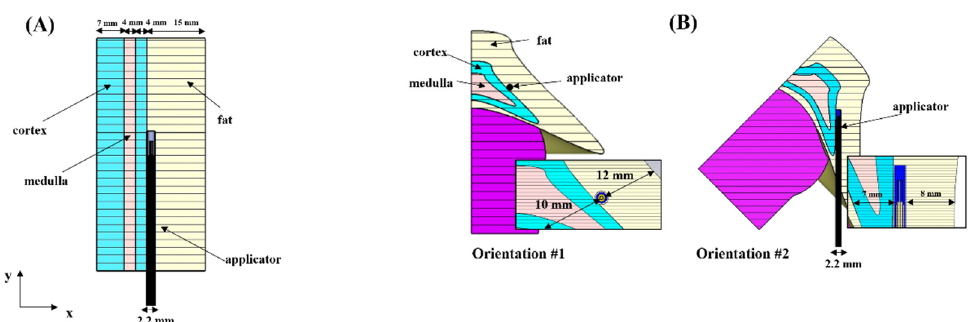
Figure 1. ( A ) Simplified geometry for modeling each functional tissue of the adrenal gland and surrounding fat layer; ( B ) 3D geometrical models of the adrenal tissues and the adjacent fat layer. The triaxial MW applicator optimized to operate at 5.8 GHz was placed parallel to the interface between fat and the adrenal cortex.